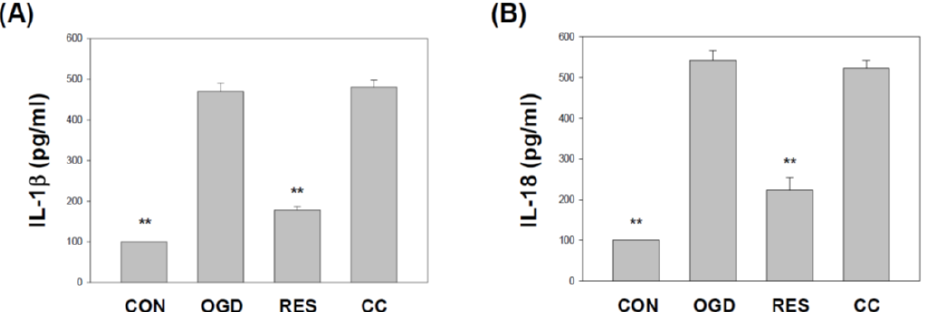
Figure 6. Resveratrol normalizes OGD-induced of IL-1 β and IL-18 under the 3D scaffold. The cell experiments under the scaffolds were divided into four groups, as described in Figure 1 and the methods section. The cell culture supernatant was harvested, and ELISA measured the secretion of IL-1 β ( A ) and IL-18 ( B ). Values are expressed as percentages of the indicated level in CON and are presented as the mean ± SEM values from three independent experiments. Specific comparison to the indicated SH-SY5Y cells with OGD ** p < 0.001 vs. cells with OGD. 2.4. Resveratrol Rescues Oxidative Stress in OGD-Treated Cells on a 3D Scaffold OGD is induced oxidative stress in HT-22 cells [54] and PC-12 cells [62]. The oxidative stress in the cells was further assessed by DCF and DHE staining assays. DCF fluorescence analysis showed that the ROS level in OGD-treated cells (Figure 7A) was significantly increased compared to the control. Furthermore, compared with the control, the DHE staining in SH-SY5Y cells treated with OGD also increased significantly (Figure 7B,C). In contrast, resveratrol treatment normalizes oxidative stress, but this effect is prevented by Compound C.